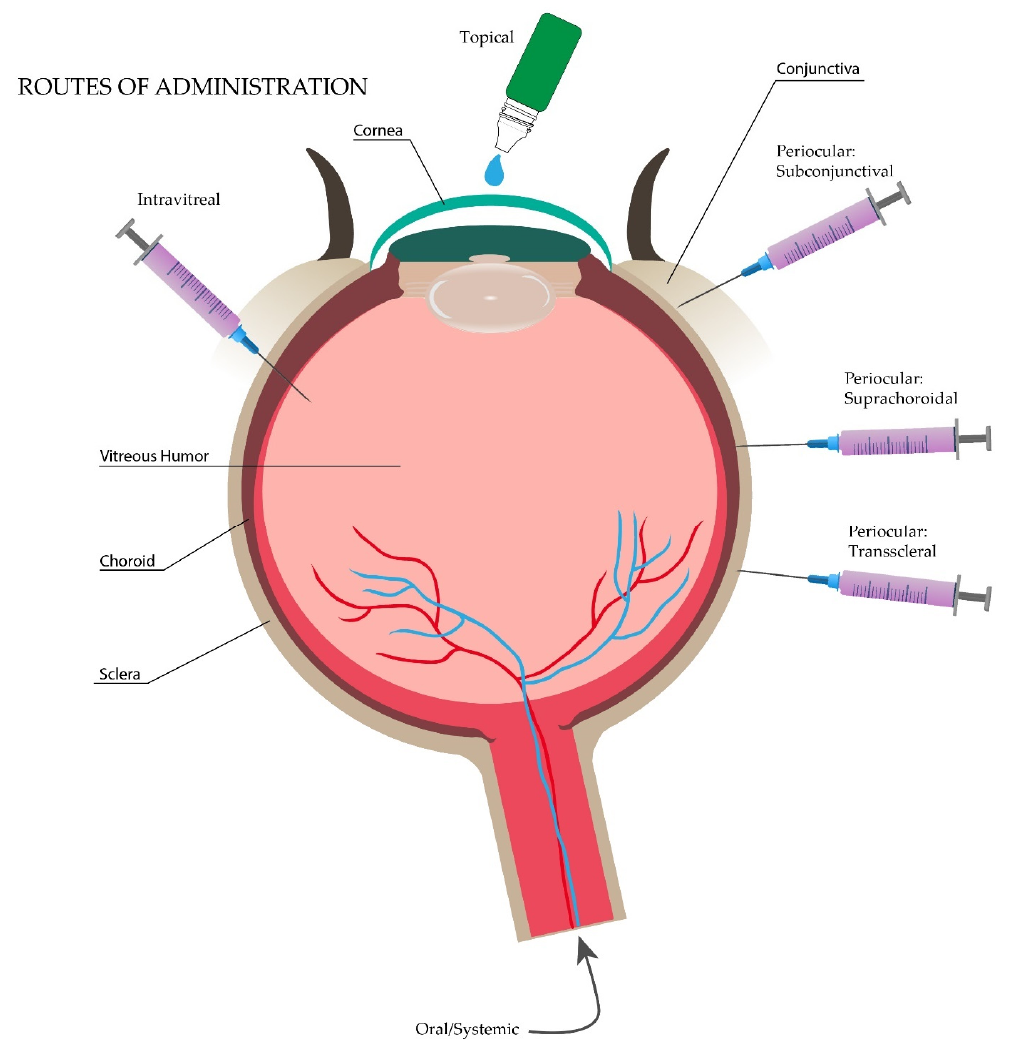
Figure 3. Ocular routes of administration.